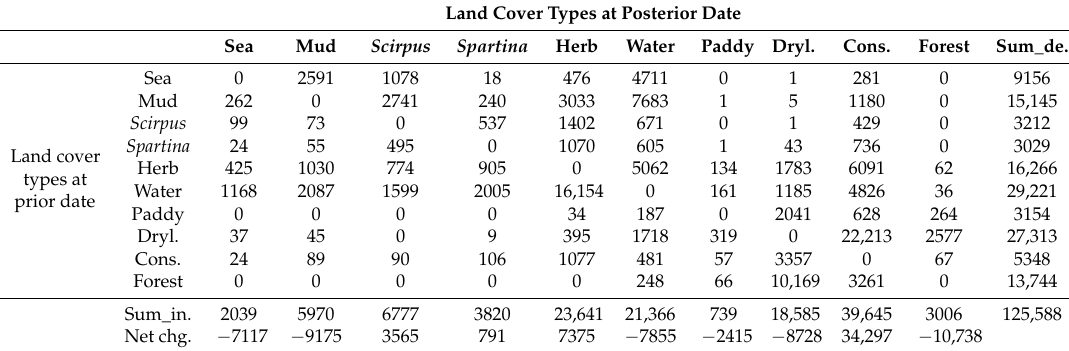
Table 5. Land cover change matrix at Hangzhou Bay in Zhejiang Province, China, during the period of 1987–2015 (ha). Land Cover Types at Posterior Date Sea Mud Scirpus Spartina Herb Water Paddy Dryl. Cons. Forest Sum_de.